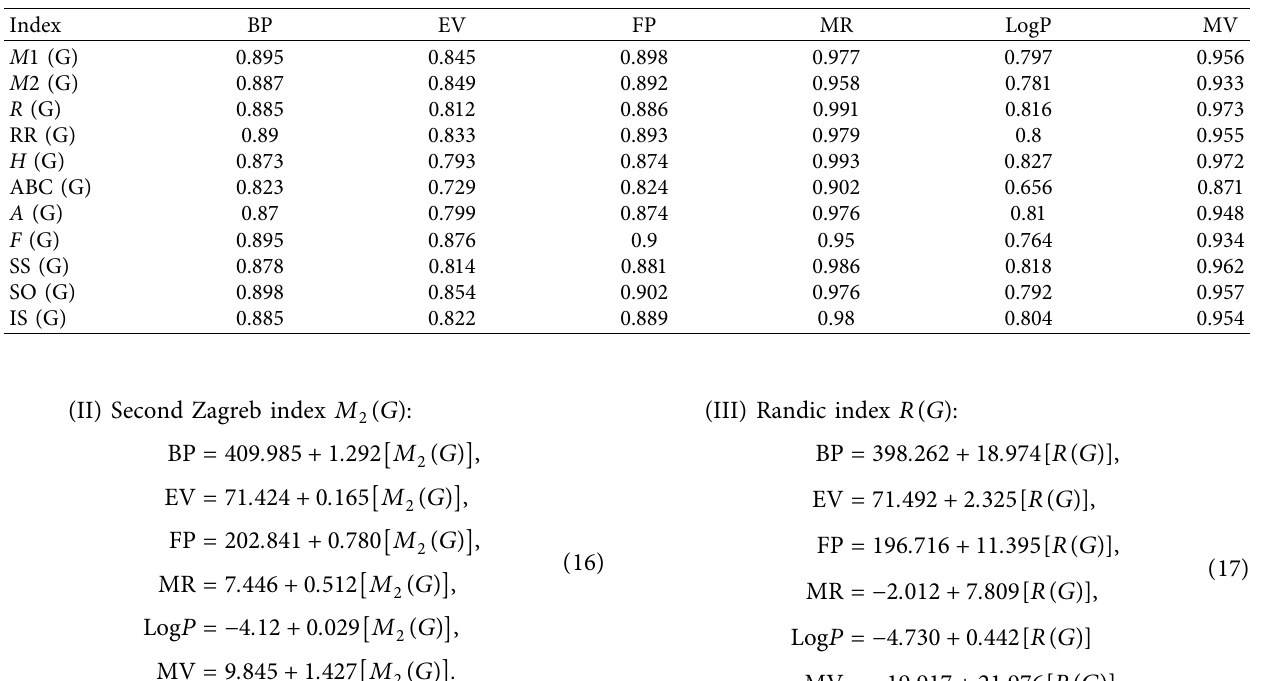
Table 14: Correlation coefficient between physicochemical properties and TI’s of breast cancer